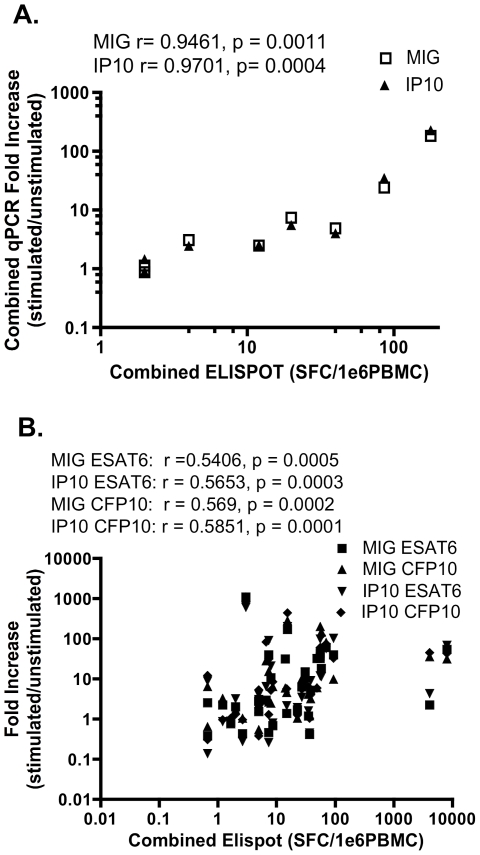
Quantitative Correlation between Elispot and qPCR assay.Correlation between MIG/IP10 qPCR and IFN-γ Elispot for CMV infection (a). The Elispot and qPCR responses to individual peptide pools were pooled and compared. Elispot SFC and qPCR fold increase of MIG and IP10 expression were significantly correlated. Correlation between MIG/IP10 qPCR and IFN-γ Elispot for Mycobacterium tuberculosis infection (b). r and p values shown; p<0.05 is significant. Data shown is taken only from individuals where both assays were performed on freshly isolated PBMC samples.